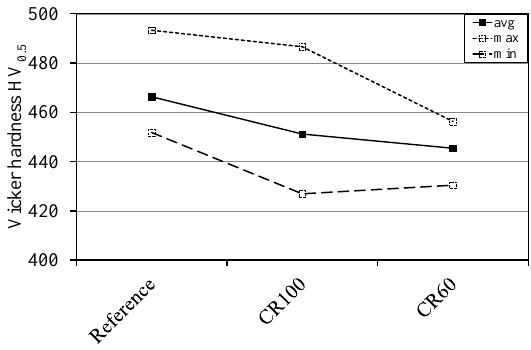
Figure 12. Average hardness in the centre of the respective samples.